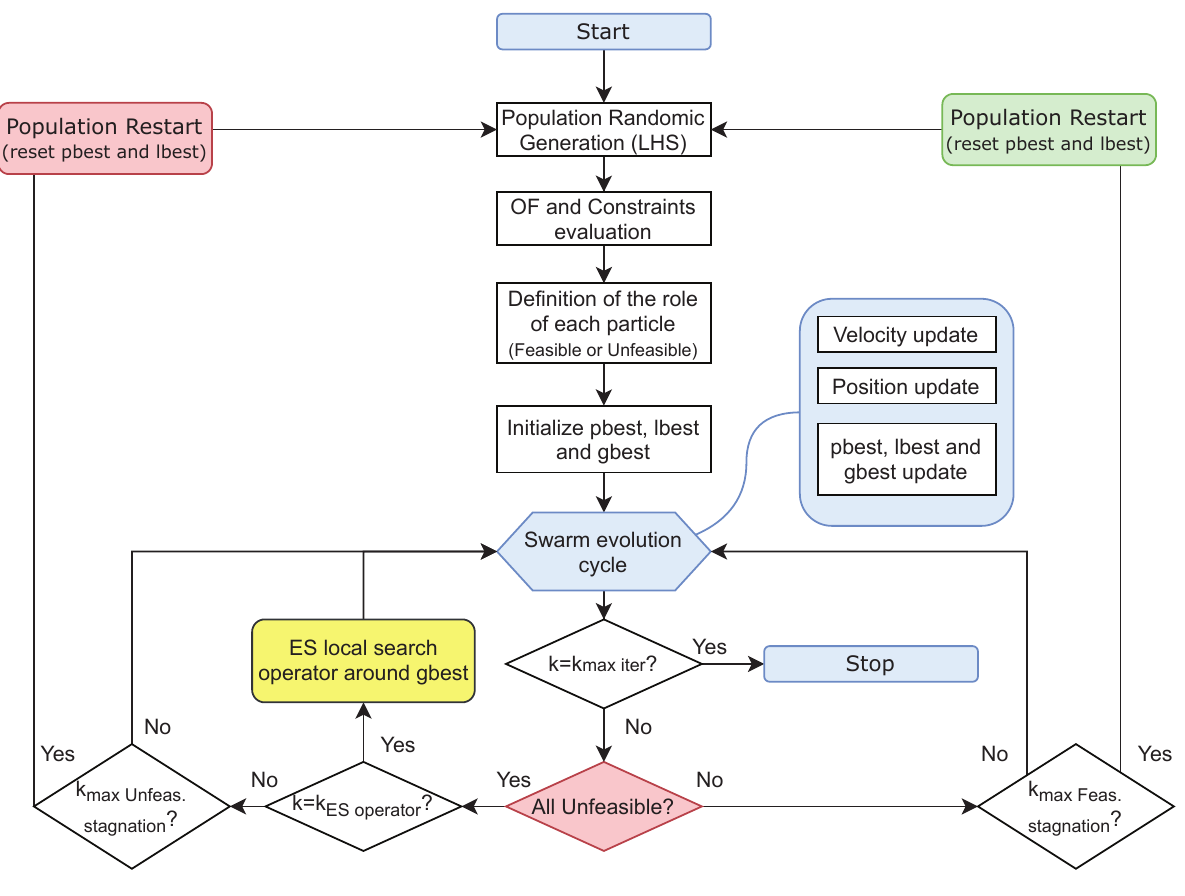
Figure 3. Enhanced PSO multi-strategy